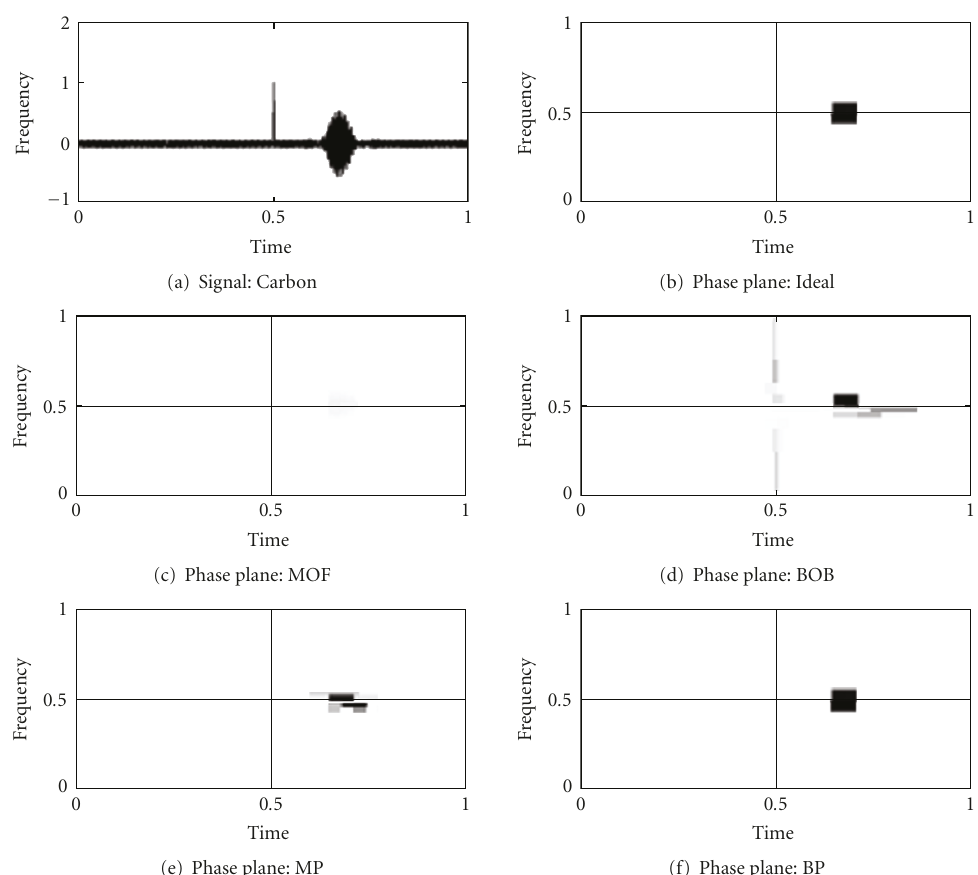
Figure 26: Analyzing the signal which is a composit of six atoms by the MOF, BOB, MP, and BP methods (adopted from